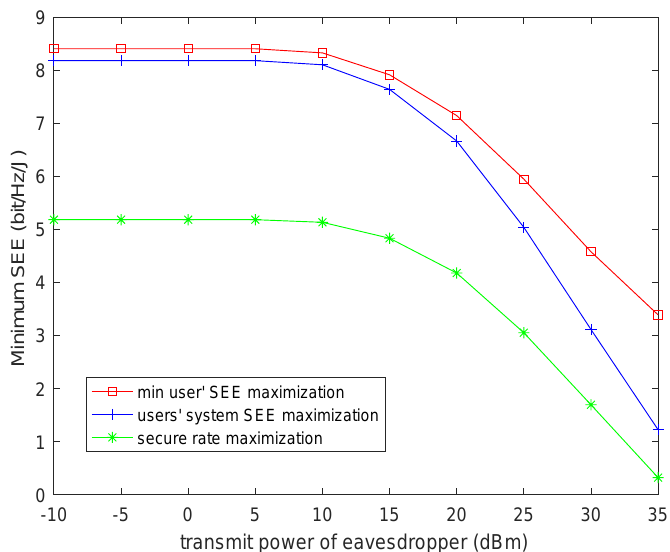
Figure 5. The minimum SEE versus the eavesdropper transmit power.